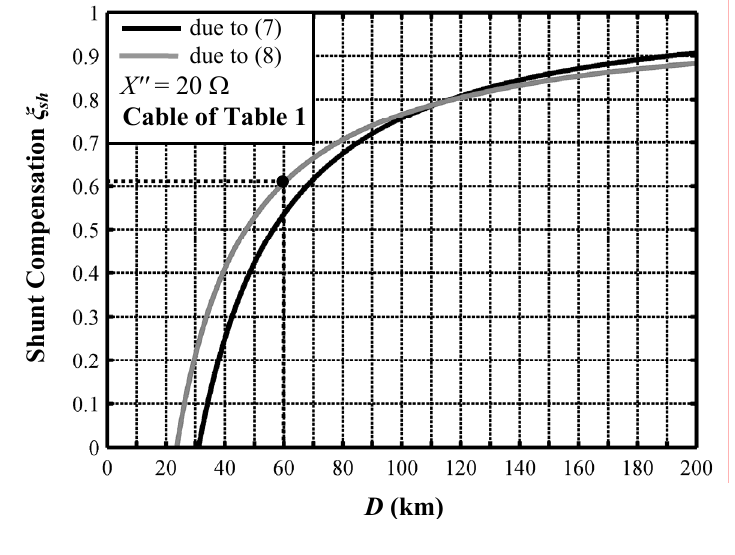
Figure 5. Reactive compensation degree as a function of cable length due to the constraints (7) and (8) for cable of Table 1 and X '' = 20 Ω .